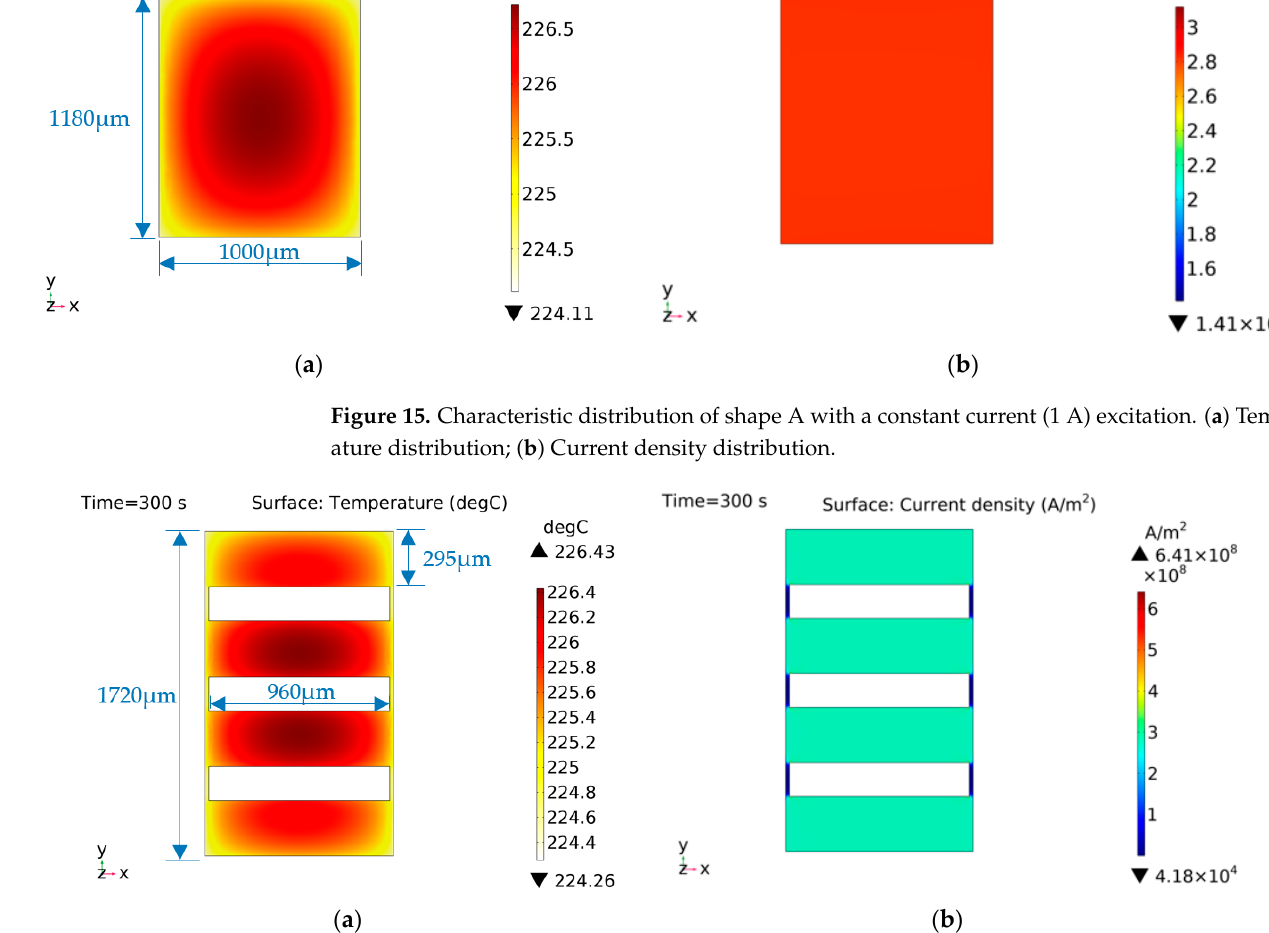
Figure 16. Characteristic distribution of shape B with a constant current (1 A) excitation. ( a ) Temperature distribution; ( b ) current density distribution.